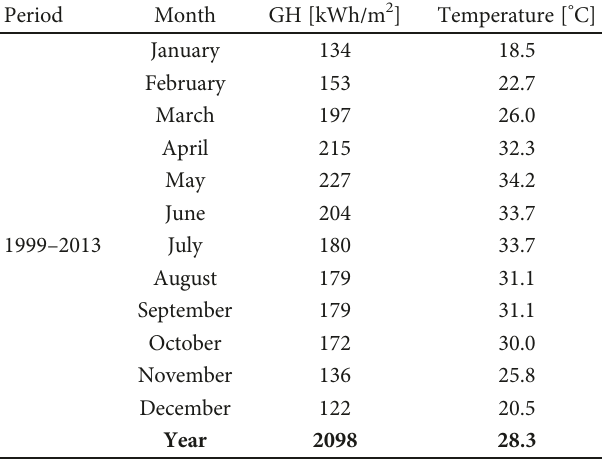
Table 3: Monthly values of GHI and temperature from Solar